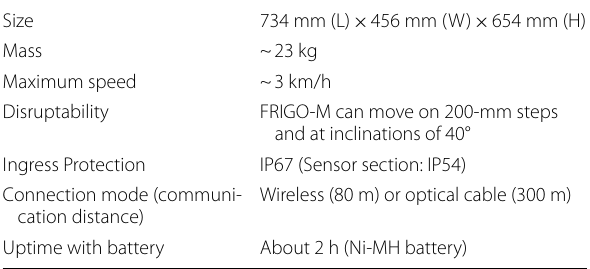
Table 4 Basic specifications of FRIGO-M